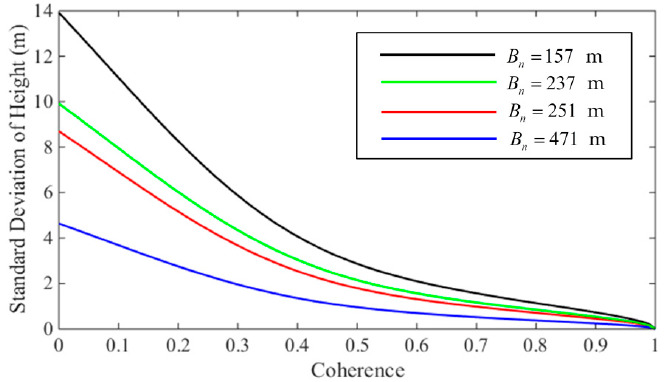
Figure 4. Standard deviation of height error over all coherence intervals for different normal baselines. As well as fusion through guided filter, the single-baseline InSAR DEMs were also fused through weighted average as contrast experiment. The weight was determined by the theoretical height error as in Equation (7). As described in Sections 2.2 and 2.3, the InSAR DEM to be fused was decomposited into a base layer and a detail layer. The averaged DEM of these InSAR DEMs was used to generate the hillshade image and the base image. The hillshade image enhanced the terrain features and was performed as the guidance image for the guided filtering of the detail image and weight image. Figure 5 and Figure 6 display the detail images and weight images before and after the guided filtering of the mountainous sample area marked by a red rectangle in Figure 3. The detail maps and weight maps of InSAR DEM I and IV are shown in Figure 5, and those of InSAR DEM II and III are shown in Figure 6. The first row and second row of Figure 5 and Figure 6 present the detail maps and weight maps before and after the guided filtering, respectively. Analyzing the first row in Figure 5 and Figure 6 , it can be seen that the detail map and weight map were related to the terrain features. Before the application of the guided filter, the images were full of “salt-and-pepper” noise. After the guided filtering, the detail maps and weight maps, shown in the second row of Figure 5 and Figure 6 , could well integrate the terrain features. Additionally, as the guided filter could combine the local spatial context information, it could reduce the random noise information in the detail maps and weight maps.